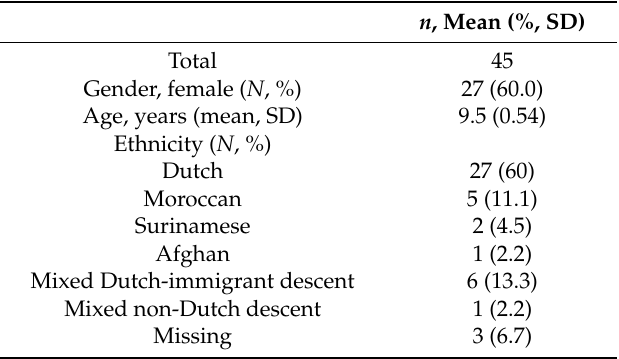
Table 1. Participant